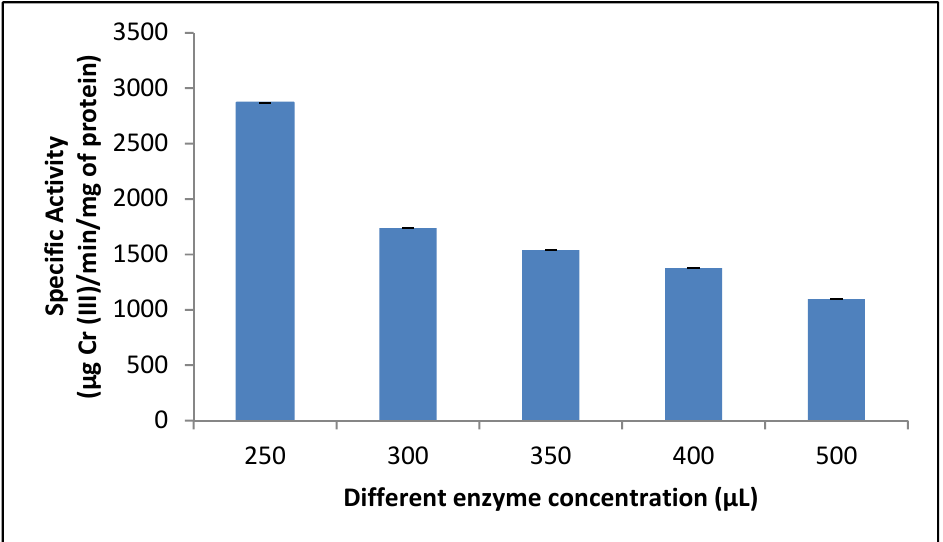
Figure 8. Effect of different enzyme concentrations on crude reductant activity in the mixed mem- brane fraction of Purpureocillium lilacinum . 1 h of incubation, pH 7.0, 100 rpm, and 37 °C.